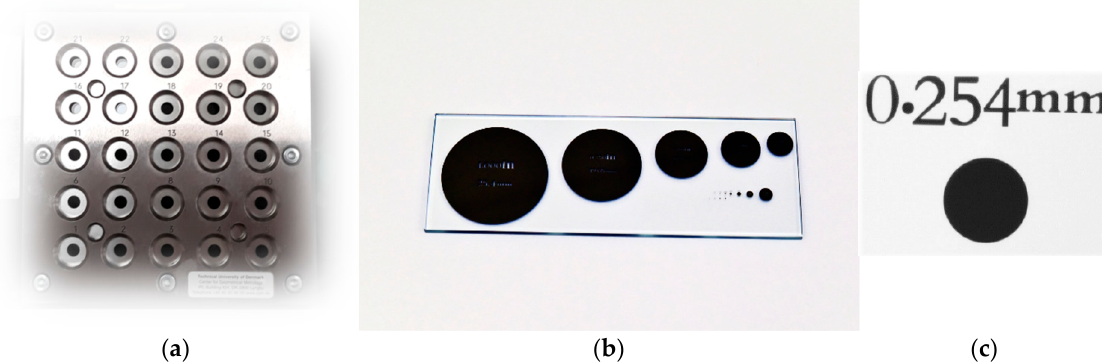
Figure 2. ( a ) Hole plate standard for optical measurements utilized during experiments, ( b ) glass plate standard (circle 254 visible on the left of the second row of circles), ( c ) circle 254 visible in optical coordinate measuring machines (OCMM) optical system.